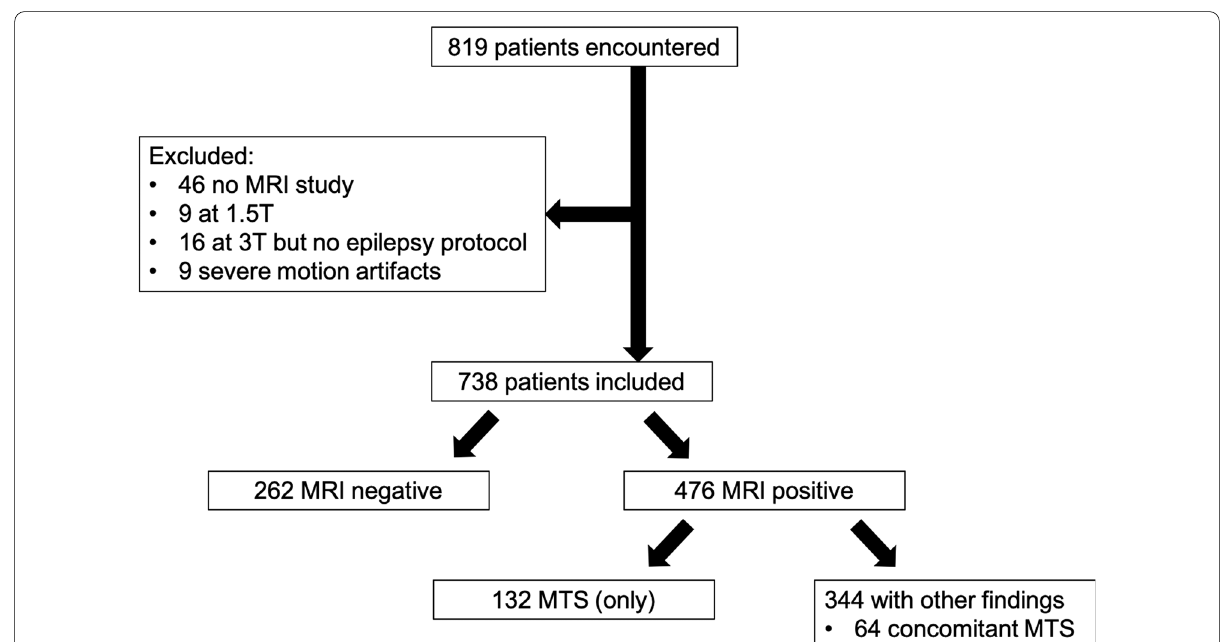
Fig. 1 Patients included in study including number of mesial temporal sclerosis (MTS)